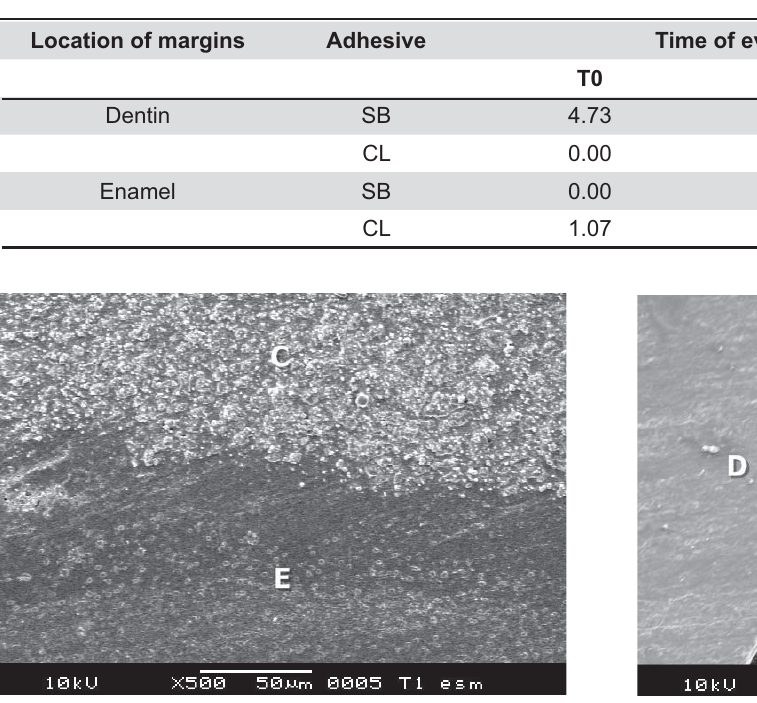
*Indicates statistical Table 2- Medians of gap measurements (in μm) within each time of evaluation